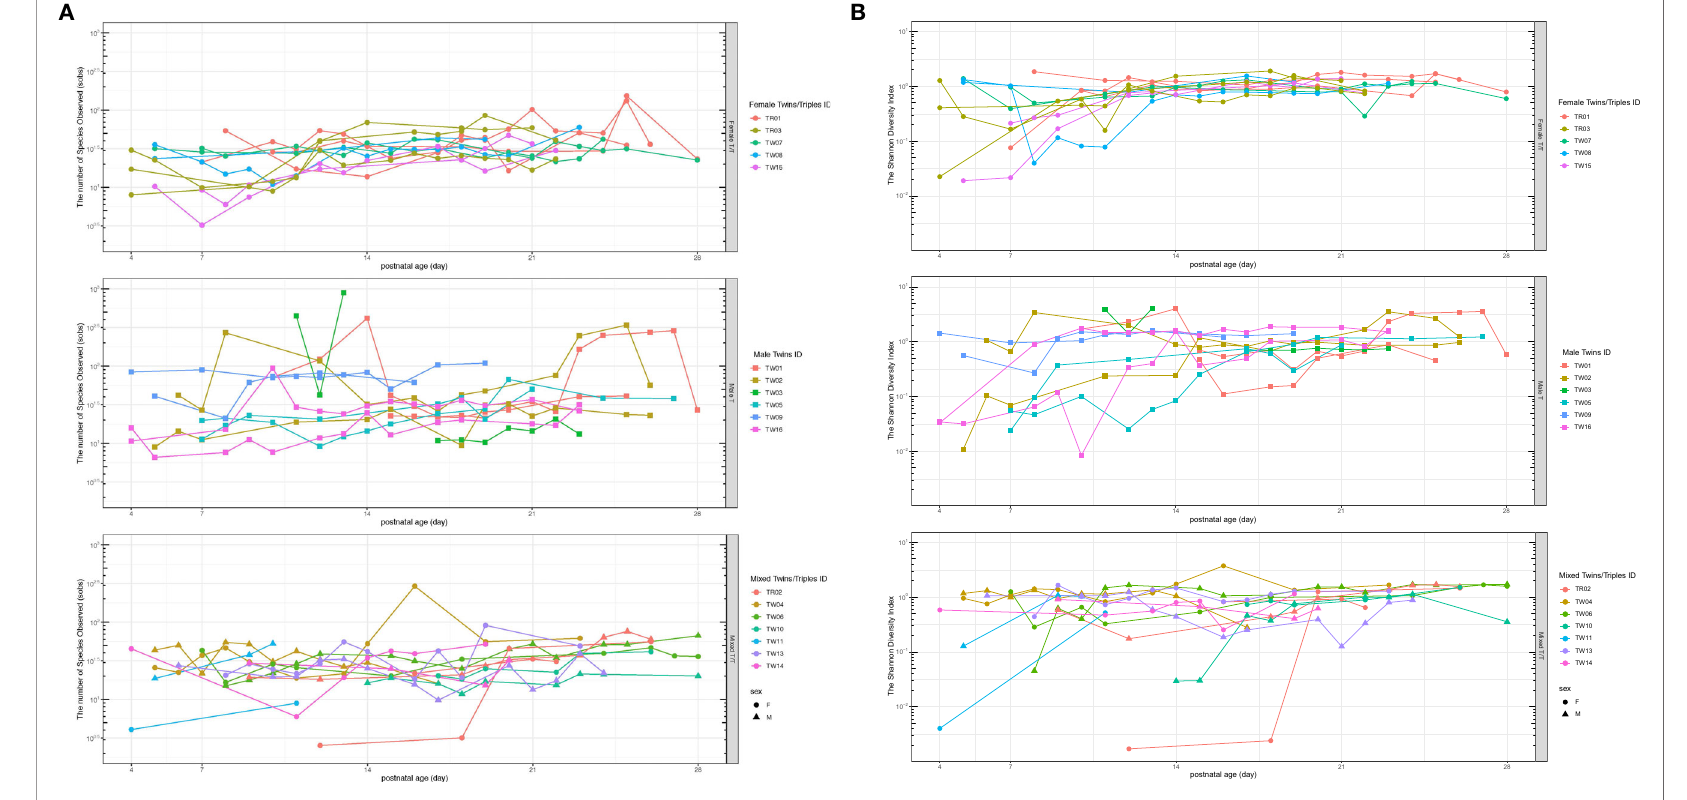
FIGURE 1 | Richness (Sobs, A ) and evenness (the Shannon diversity, B ) of the bacterial community among twins/triplets over time. The subplots from top to bottom are for Female T/T, Male T, and Mixed T/T groups respectively. Each line in the spaghetti plot represents one baby and the same color in each subplot represents babies from the same mother. Sobs, species of